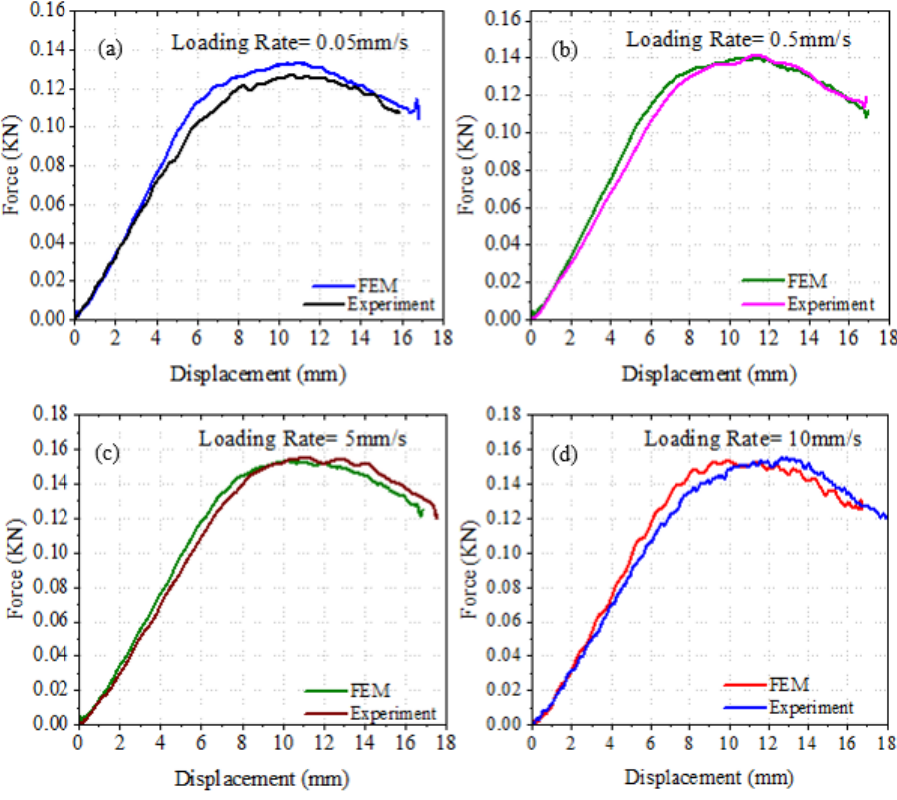
Figure 7. Comparison between experimental and FEM predictions for the behavior of long-span beams; ( a ) Loading rate = 0.05 mm/s, ( b ) Loading rate = 0.5 mm/s, ( c ) Loading rate = 5 mm/s, ( d ) Loading rate = 10 mm/s.